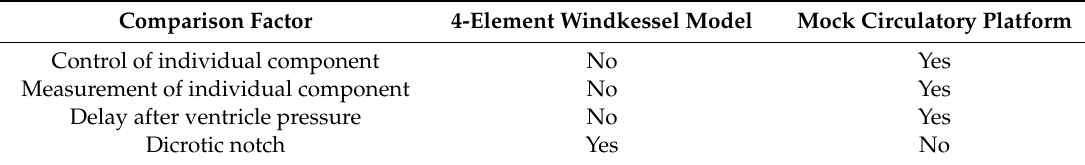
Table 4. Comparison of the mock circulatory platform and the 4-elements windkessel model. Comparison Factor